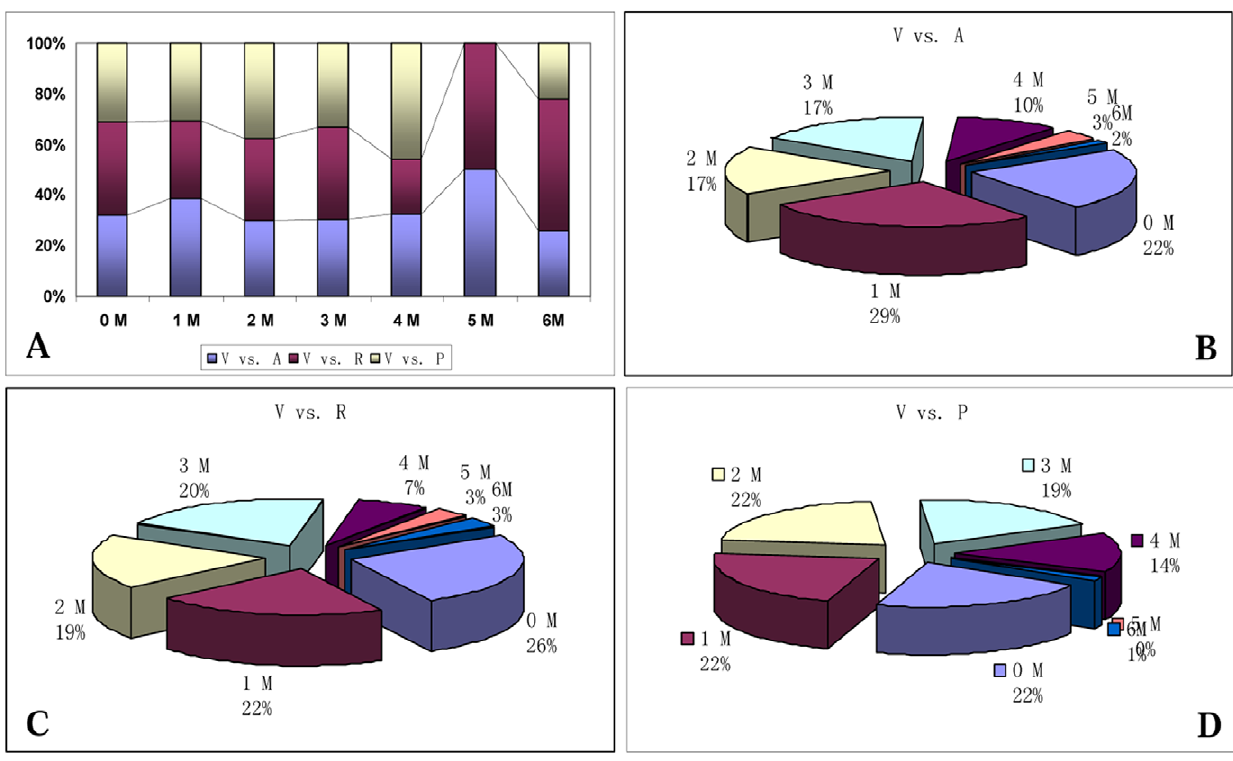
Figure 1. Comparison of divergence of orthologous miRNA sequences among grapevine, Arabidopsis , rice and poplar. V vs. A: grapevine miRNA sequences compared to those of Arabidopsis ; V vs. R: grapevine miRNA sequences compared to those of rice; V vs. P: grapevine miRNA sequences compared to those of poplar.